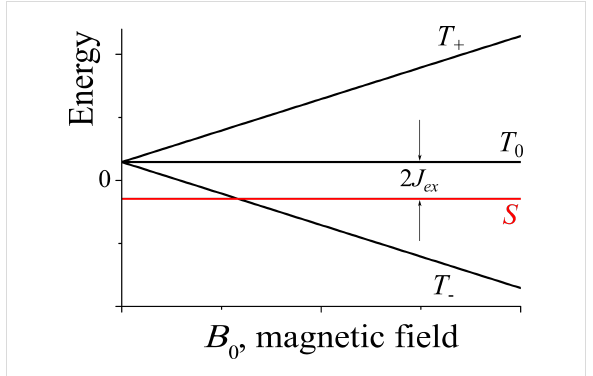
Figure 3: Schematic representation of the energy levels of a radical pair. The spacing between the S and T 0 levels is equal to 2 J ex . In radical pairs, typically, the singlet state is lower in energy at B 0 = 0, al- though the opposite situation can also be met. The splitting between the triplet levels linearly increases with the magnetic field due to the Zeeman